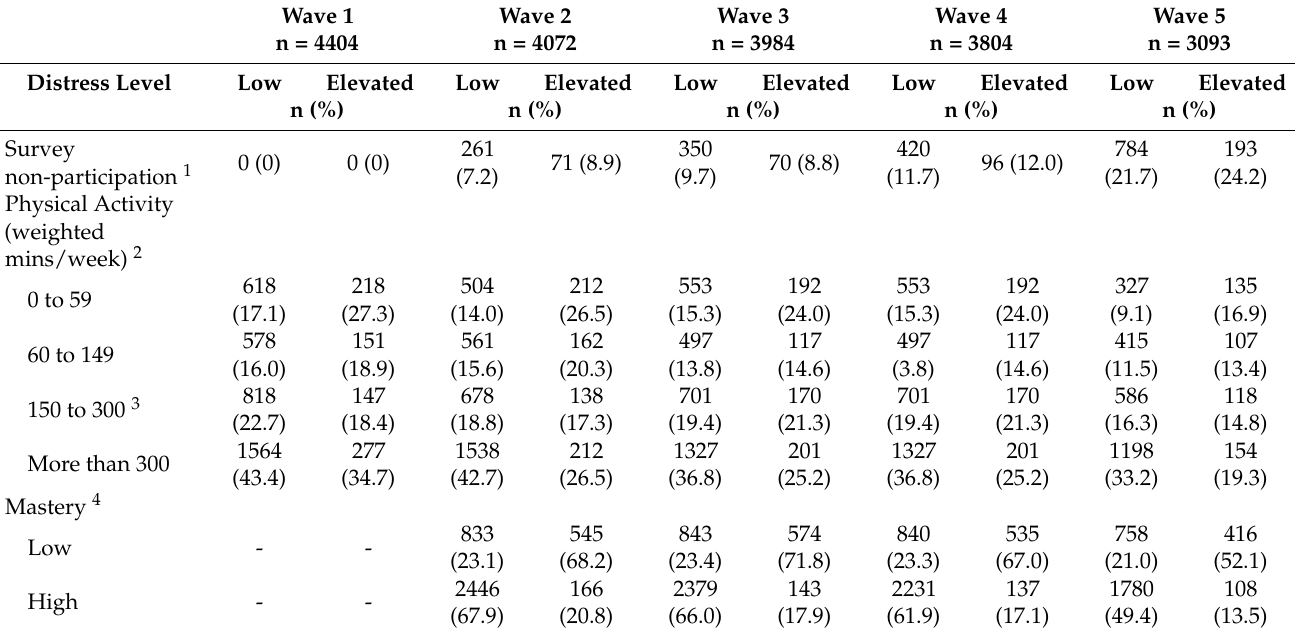
Table 3. Physical activity and mastery level of participating sample at each timepoint.